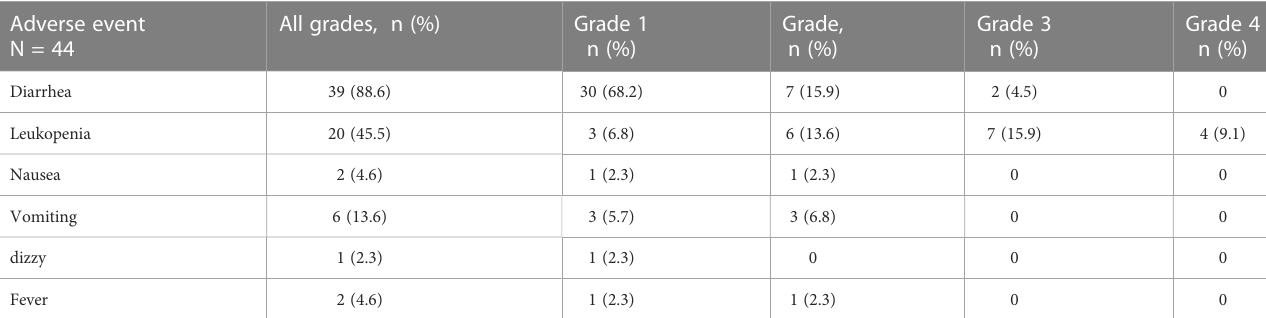
TABLE 4 Adverse